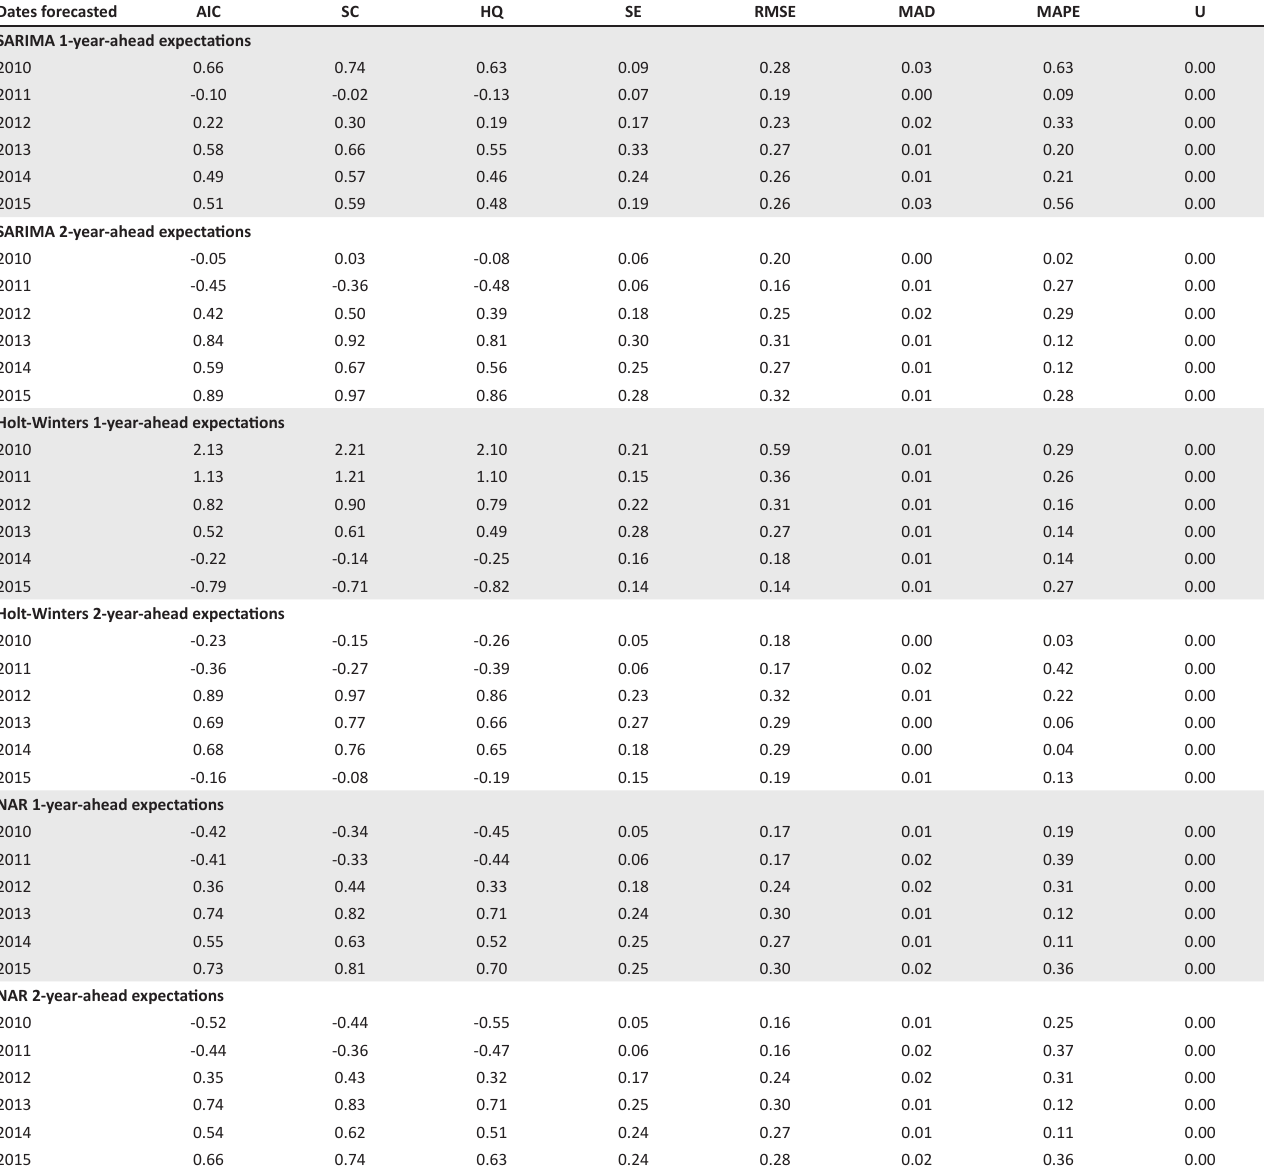
TABLE 1-A1: Inflation accuracy comparison with the International Monetary Fund – Yearly approach. Dates